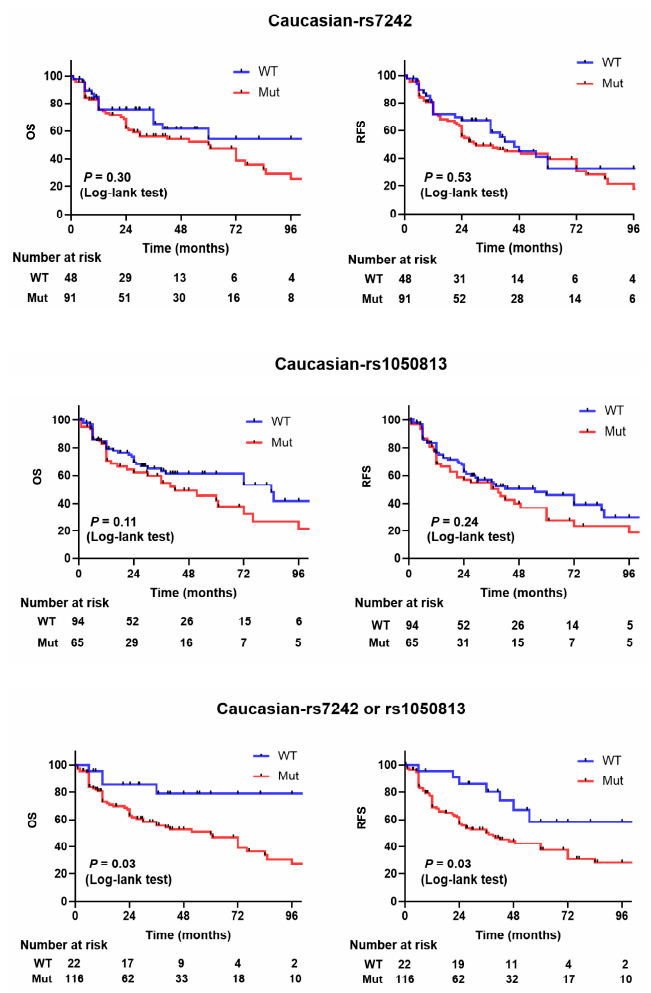
Figure 1. Kaplan–Meier survival curves for PAI1 WT vs. mutation (rs7242 alone, rs1050813 alone, or either or both rs7242 and rs1050813) in pooled cohort (Cohorts 3 and